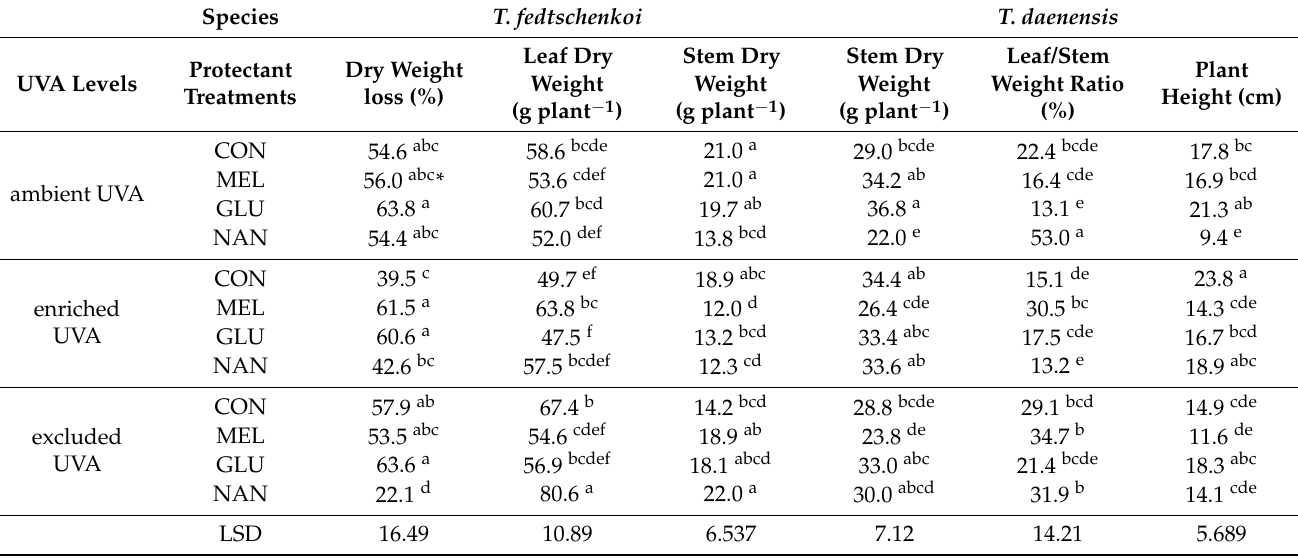
Table 2. Significant interaction effects of UVA levels (ambient, enriched, excluded) with protectant compounds [water (control), melatonin, glutathione, iron-zinc nanofertilizer] on dry weight loss, leaf dry weight, and stem dry weight of Thymus fedtschenkoi , as well as on stem dry weight, leaf to stem dry weight ratio, and plant height of T. daenensis . Within each column, different letters indicate significant